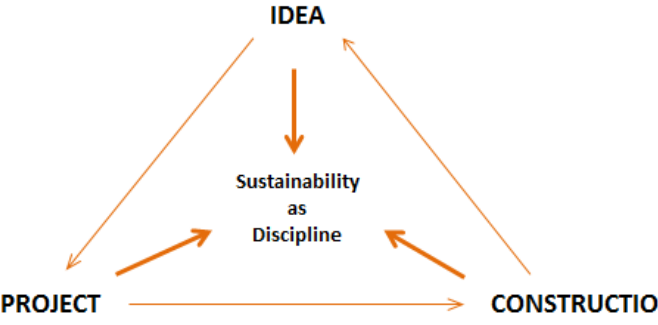
Figure 1. An a posteriori conception of